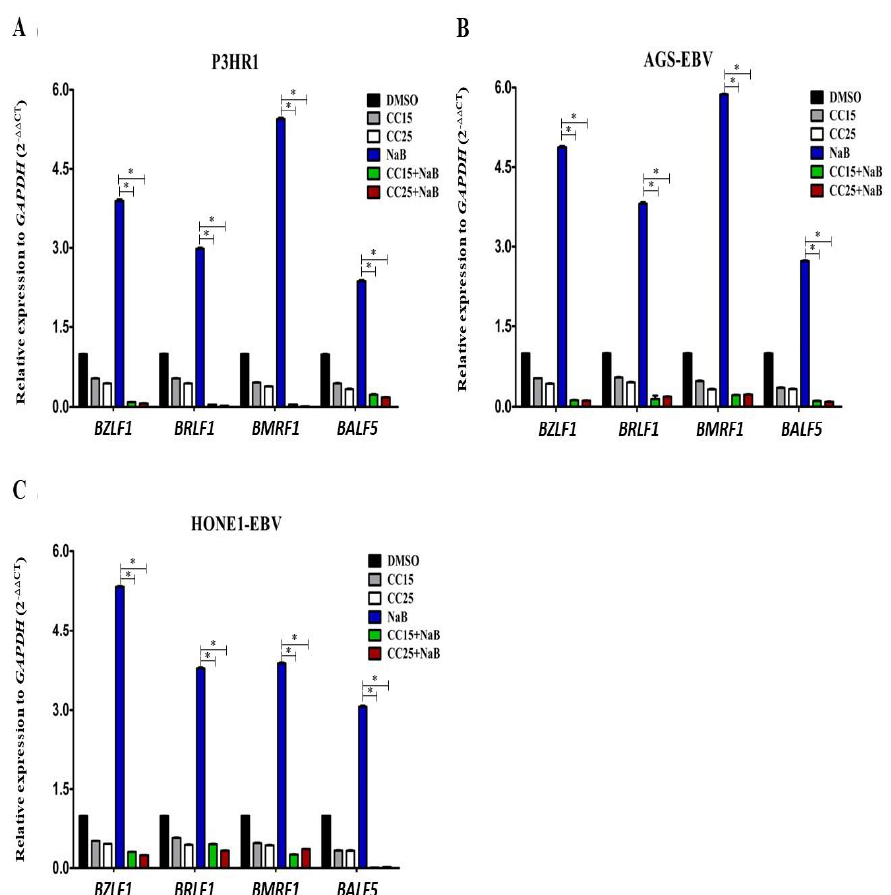
Figure 2. Andrographolide inhibits the induction of EBV lytic reactivation. Cells were treated with and without andrographolide at CC 15 and CC 25 for 3 h, and NaB was subsequently added, and further incubated for 48 h. The expression levels of BZLF1, BRLF1, BMRF1 and BALF5 genes in P3HR1 ( A ), AGS-EBV ( B ) and HONE1-EBV ( C ) cells were examined using qRT-PCR. *: p < 0.05.